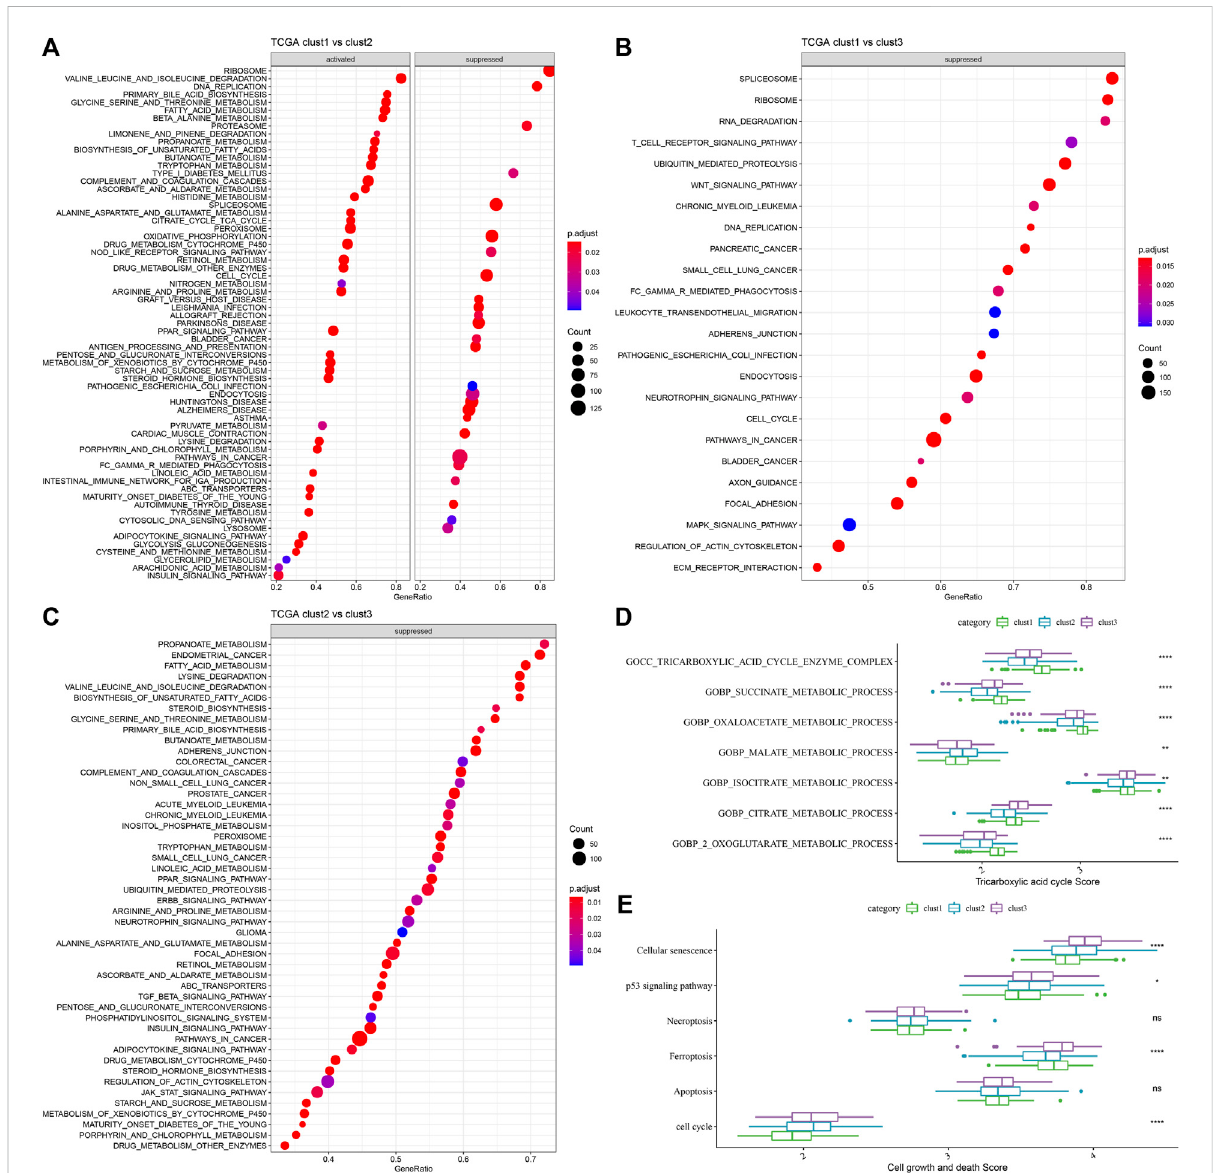
FIGURE 4 GSEA analysis of the 3 molecular subtypes. (A) Clust1 vs. clust2 GSEA analysis results in TCGA-LIHC dataset; (B) Clust1 vs. clust3 GSEA analysis results in TCGA-LIHC dataset; (C) Clust2 vs. clust3 GSEA analysis results in TCGA-LIHC dataset; (D) Comparison of TCA related pathway